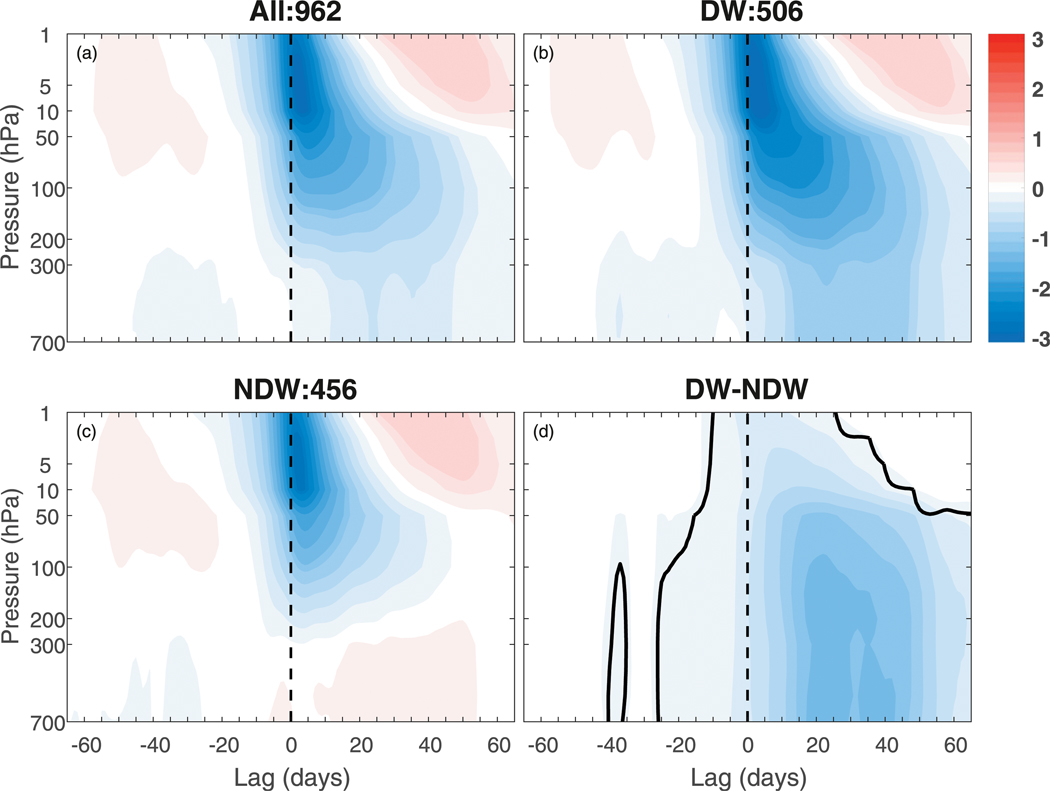
The composite evolution of the NAM index for (a) all SSWs calculated in the entire ensemble of integrations and (b) DW-propagating SSWs calculated using the Karpechko et al. (2017) criteria (see our section 2c); (c) as in (b), but for NDW-propagating SSW events; and (d) the composite difference between the DW- and NDW-propagating events (DW–NDW). The units are in standard deviations. The thick black line in (d) represents statistical significance at the 95% level.